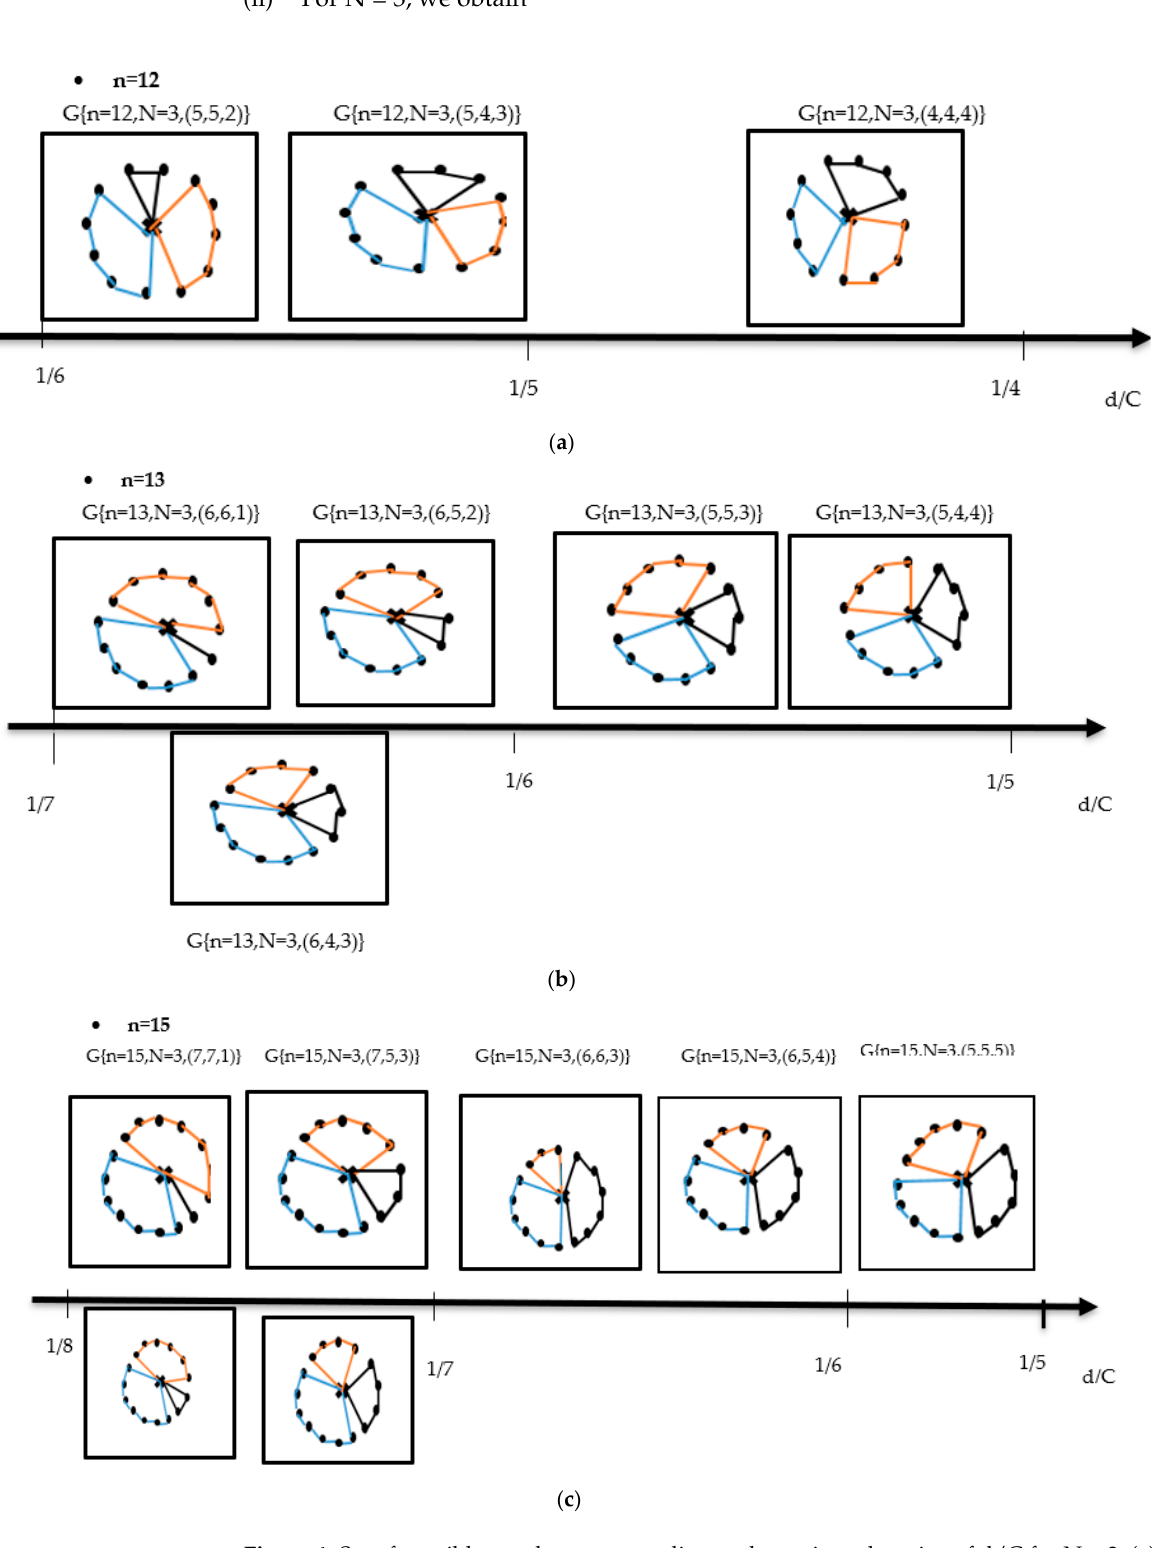
Figure 4. Set of possible graphs corresponding to the various domains of d/C for N = 3, ( a ) n = 12, ( b ) n = 13, and ( c ) n = 15.